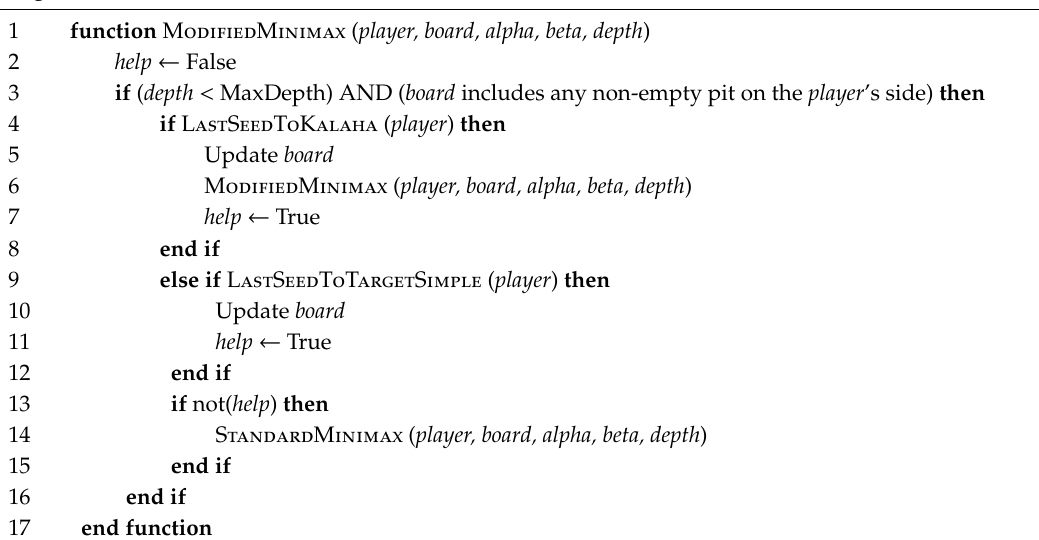
Algorithm 3. Modified